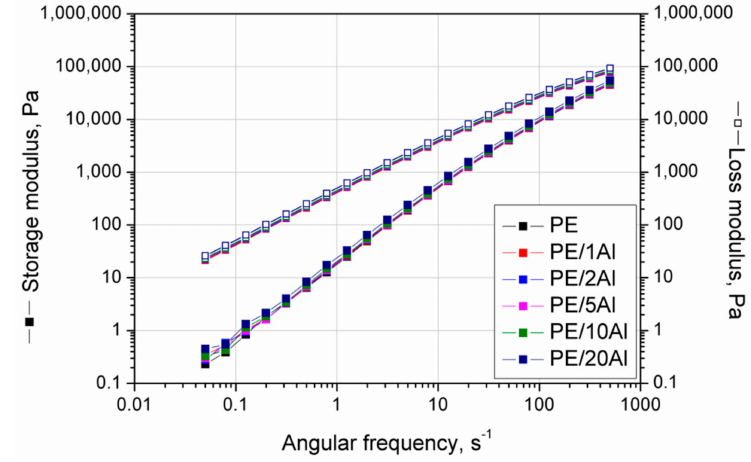
Figure 8. Storage and loss modulus vs. angular frequency curves of PE and PE / Al